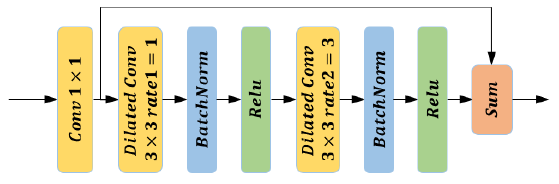
Figure 5. ResConv module used to refine the features and reduce network